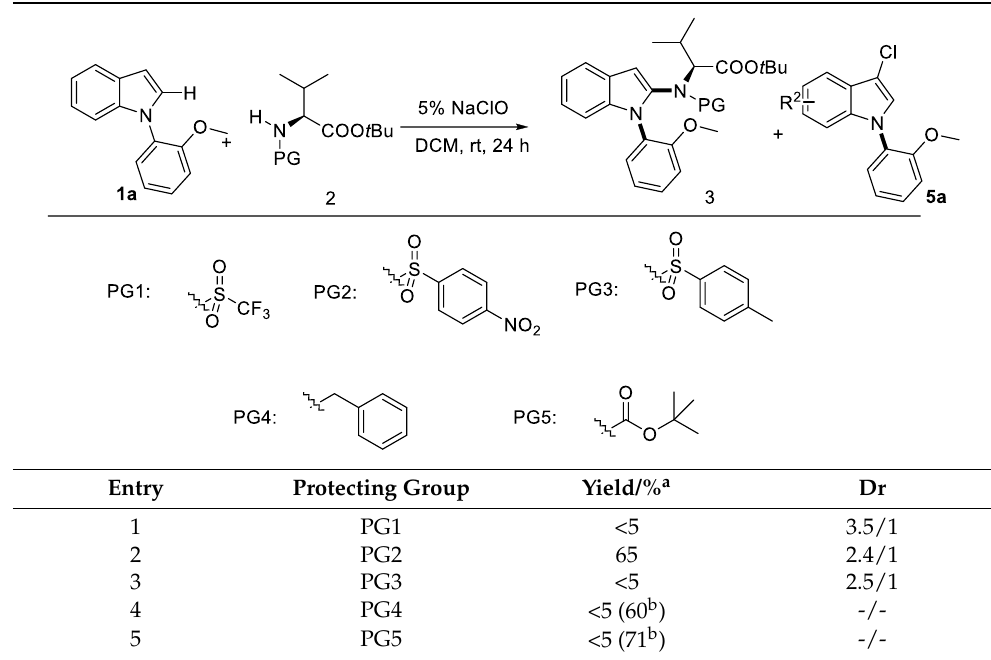
Table 2. Protecting group screening for indole C–N axially chiral construction.